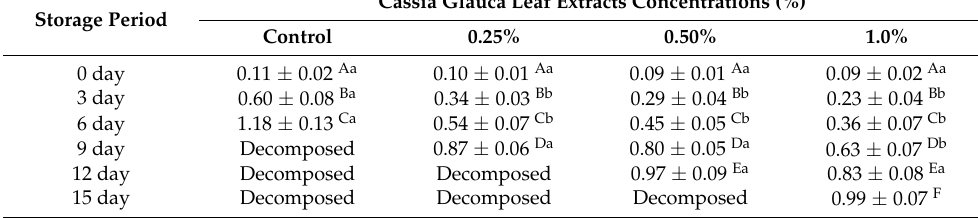
Means carrying a different capital or small superscript are significantly different ( p < 0.05) in the same column and row,